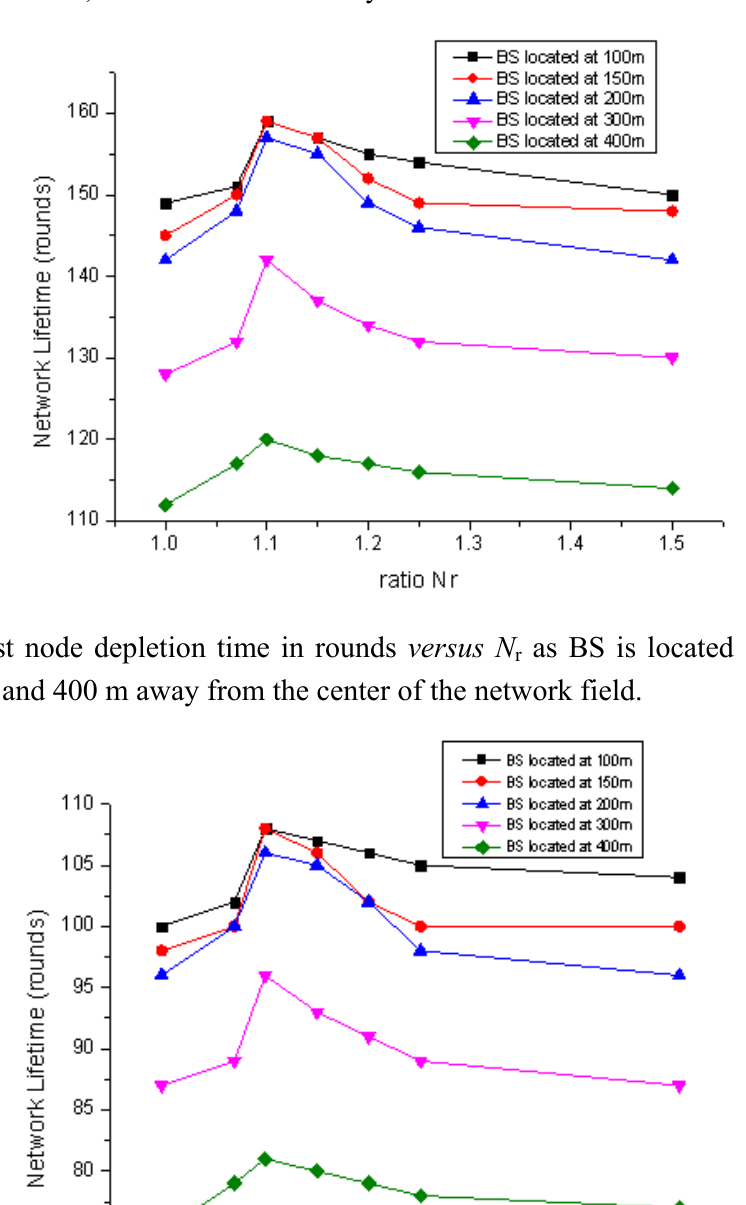
as base station (BS0 is located r